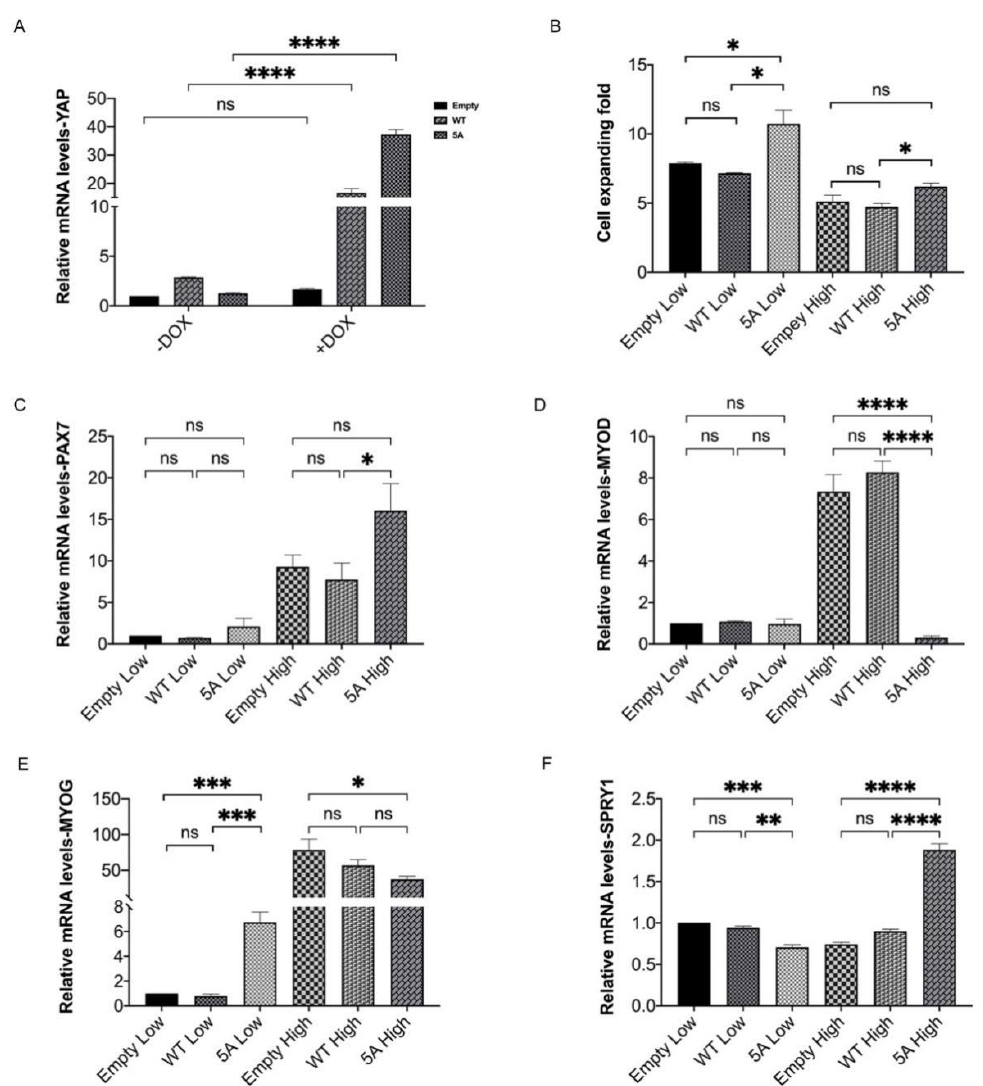
Figure 7. Overexpression of constitutively active YAP promotes cell proliferation and stemness maintenance of MuSCs. The 2 μg/mL Dox was used for 48 h to induce the expression of YAP before harvesting. ( A ) Expression of YAP induced by Dox in control MuSCs transfected with empty vectors and MuSCs transfected by wild-type (WT) YAP and phosphorylation mutational YAP (5A). ( B ) The cell expanding fold of MuSCs after Dox induction under low and high densities. ( C – F ) Expression of PAX7 , MYOD , MYOG, and SPRY1 under indicated conditions by qPCR analysis. Mean ± SD from three independent experiments. Significance was analyzed by two-way ANOVA for ( A ) and one-way ANOVA for ( B – F ). * p < 0.05, ** p < 0.01, *** p < 0.001, **** p < 0.0001, ns, not significant ( p > 0.05).